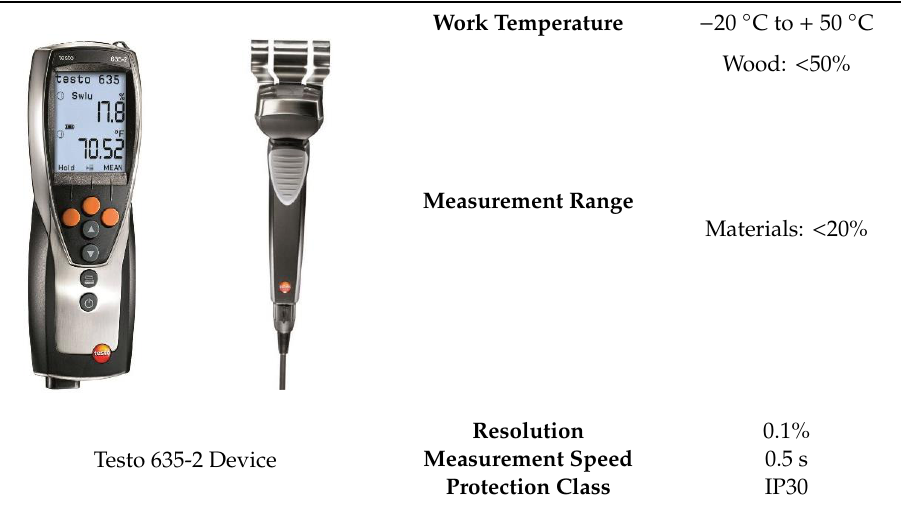
Table 1. Technical specifications of the Testo 635-2 device.